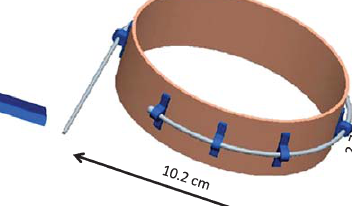
Fig. 2. Fabrication procedures of a silicone stomach.